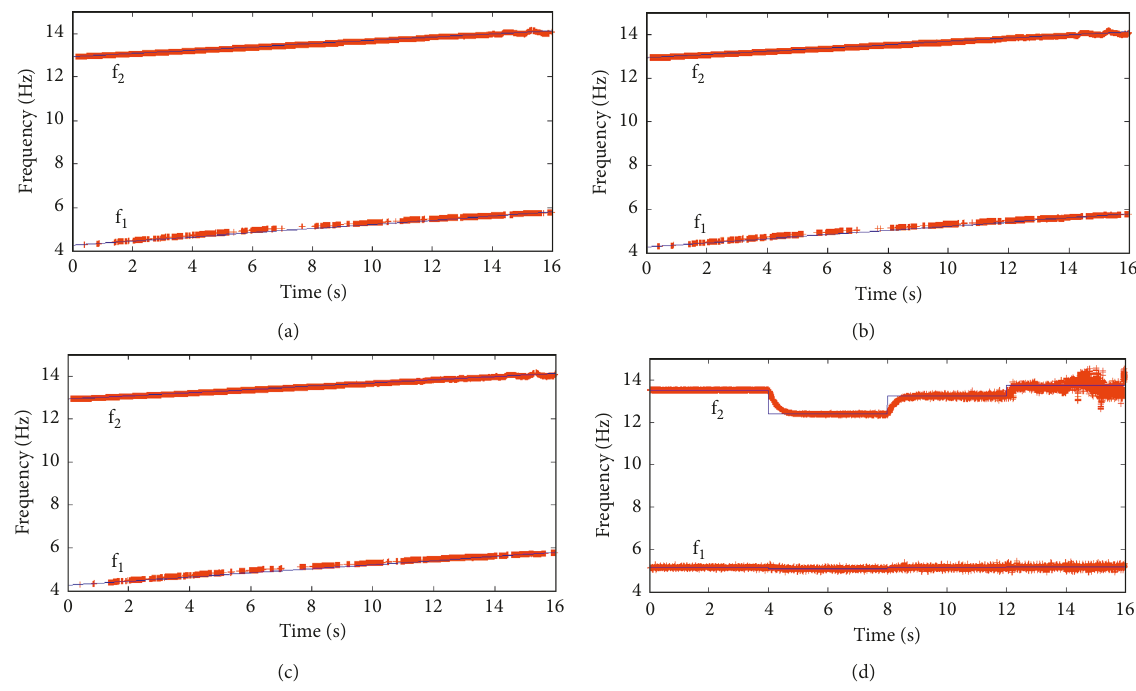
Figure 12: Frequency identification results of the first two modes using vibration signals with different SNR values for simulation case 2 (blue line represents the theoretical value of the frequency, and red line represents the identified value of the frequency): (a) no noise; (b)